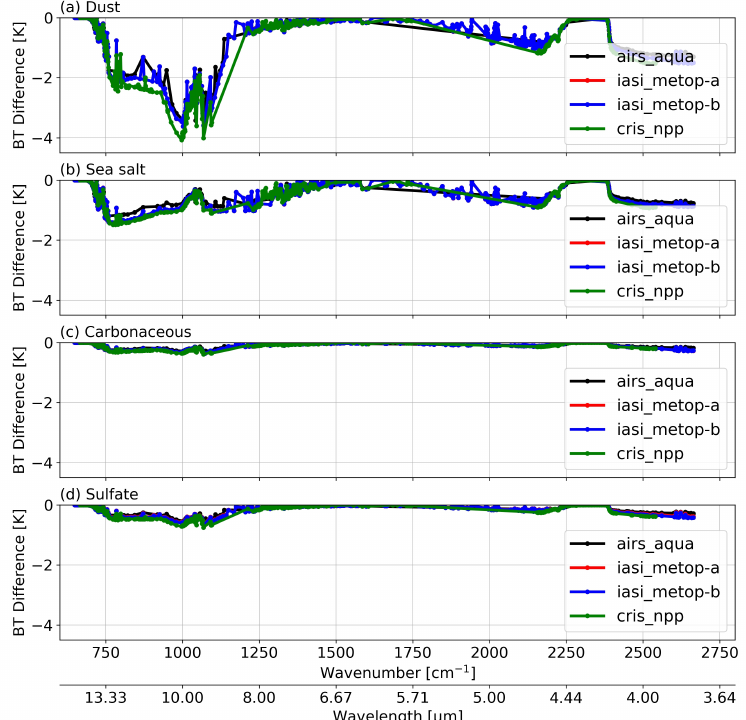
Figure 3. Average simulated brightness temperature (BT) differences for high-spectral IR sensors between AER and CTL (AER minus CTL) as a function of wavenumber (cm before BC and QC where NGAC v2 AOD at 550 nm > 0.3 and species fraction > 0.65 over 1–28 August 2017 are included in statistics. ( a ) dust, ( b ) sea salt, ( c ) carbonaceous, and ( d ) sulfate